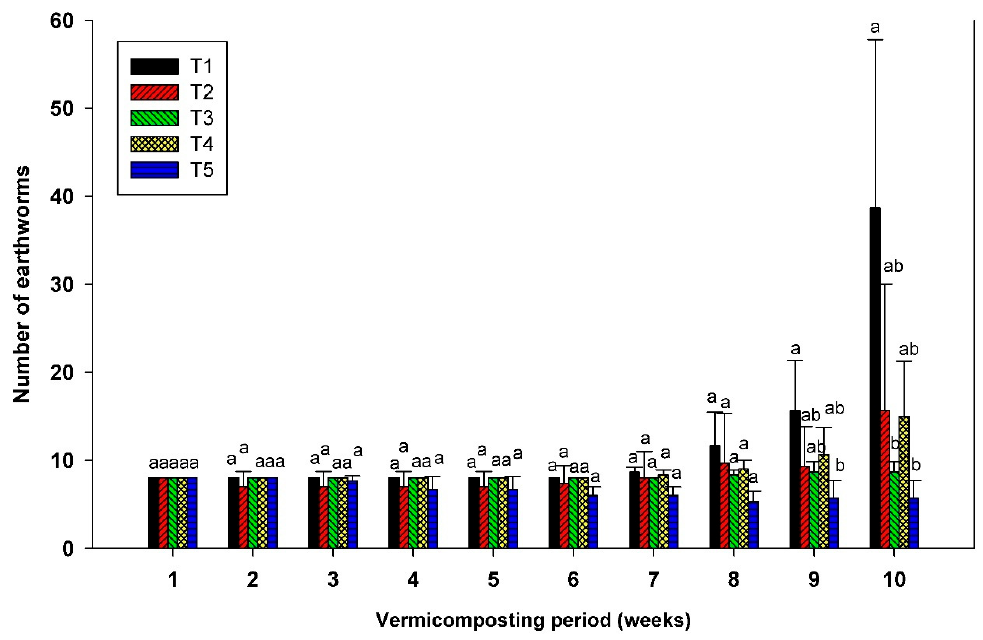
Figure 1. Mean ± SD values of number of earthworms followed by different letters in the same week are different in terms of statistical significance ( p -value < 0.05) between the combinations involved.